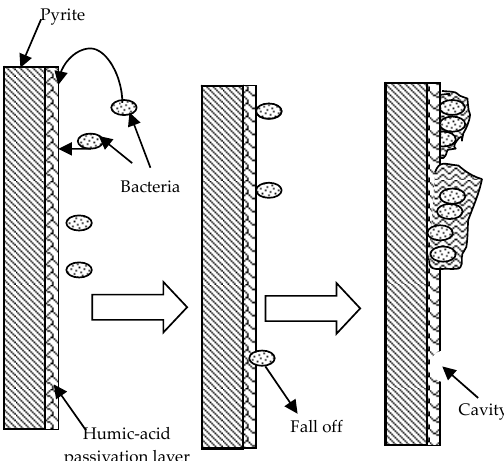
Figure 9. Mechanism of destruction of humic-acid passivation layer by bacteria.